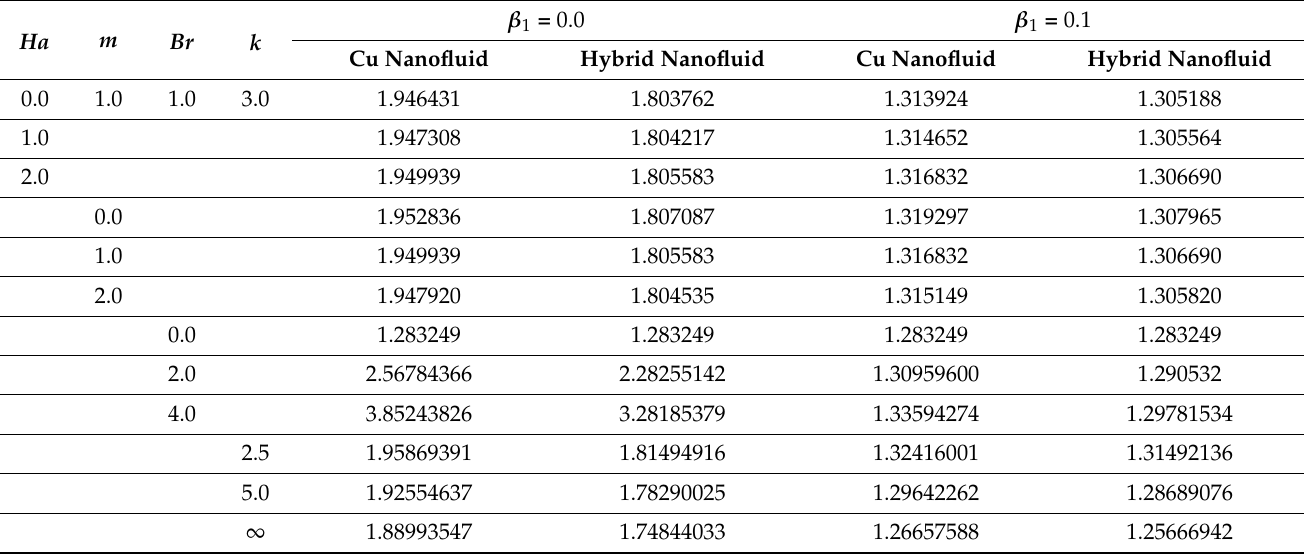
Table 3. Variation of heat transfer coefficient with γ 1 = 1.0 and q = − 0.2.